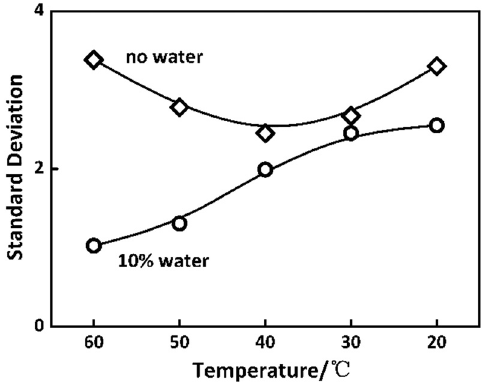
Figure 6: Average size of PAN coils in solution with di ff erent water content during cooling process. Figure 7: The standard deviation of size distribution of PAN coils in solution with 0% and 10% water during the cooling process.